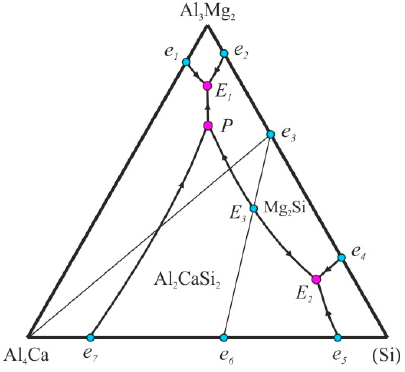
Figure 1. Polythermal projection of the Al-Ca-Mg-Si system in the aluminum corner. Table 3. Calculated parameters of invariant reactions in the Al-Ca-Mg-Si system.